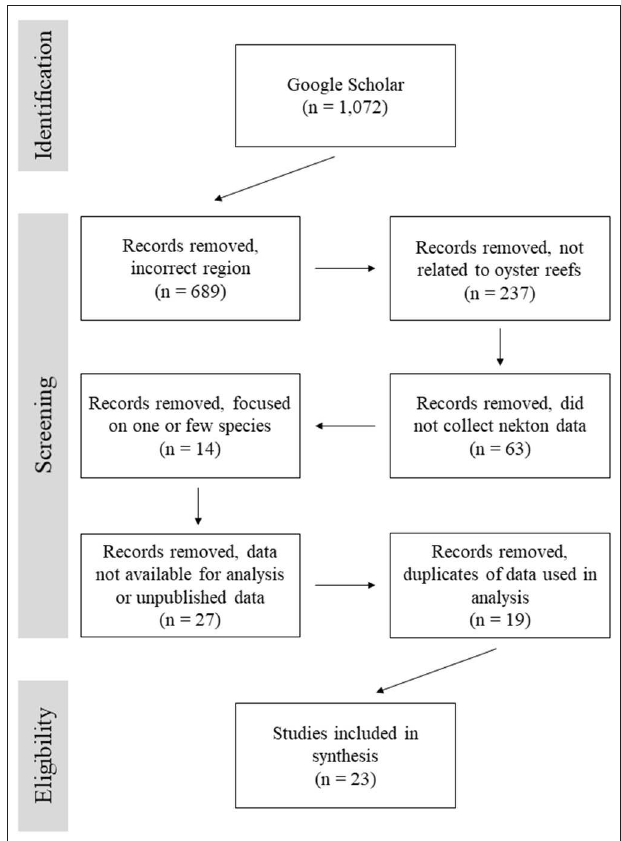
FIGURE 1 | Flow diagram for records search documenting number of records identified and screened for inclusion in this data